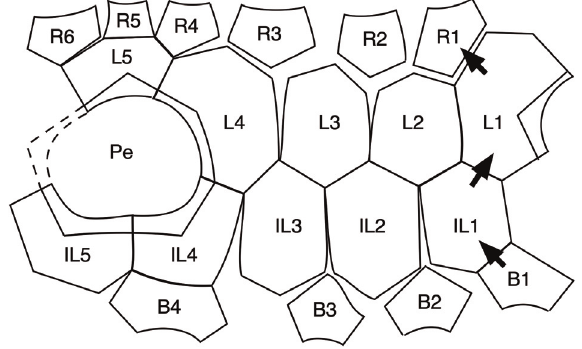
Fig. 7. Plate diagram for Macrocystella Callaway, 1877 to show four closed plate circlets, large periproct (Pe) surrounded by five thecal plates (IL4, IL5, L1, L4 and L5). Arrows indicate the conventional positions of the first plates in each circlet. B1–B4, basals; IL1–IL5, infralaterals; L1–L5, laterals; R1–R6, radials. Redrawn from Paul (1968a, fig. 3, p.